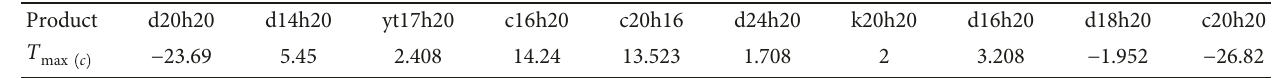
Table 5: T max c values for the 10 products at the beginning of the severe fault